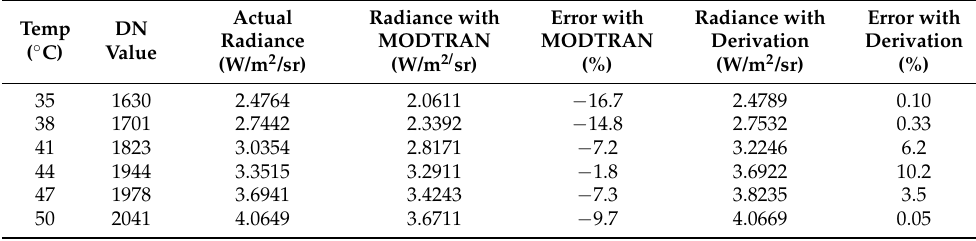
Table 8. Comparison of inversion results for heating